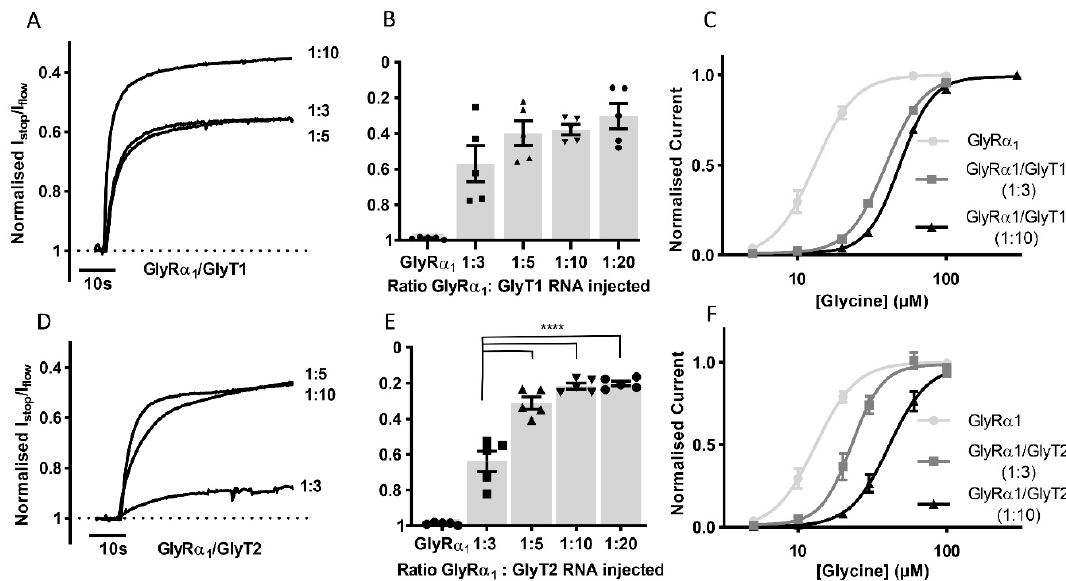
Figure 3. The impact of GlyT expression levels on GlyR α 1 currents. Example traces from co-expressed oocytes expressing different ( A ) GlyT1 and ( D ) GlyT2 densities showing normalised I stop /I flow reduction of GlyR α 1 currents ( B , E ) Histograms show increasing the ratio of GlyR α 1 : GlyT cRNA injected in oocytes increases the normalised I stop /I flow ratio when co-expressed with GlyT2 but not GlyT1. Significance was tested using a one-way ANOVA and Dunnett’s post-hoc test and **** indicates p < 0.0001. No significant difference was found between values for different GlyT1 ratios. ( C , F ) Glycine dose responses for GlyR α 1 and GlyR α 1 /GlyT1 or GlyR α 1 /GlyT2 at 1:3 and 1:10 injected cRNA ratios. Fast flow currents were normalised to I max and fit to the Hill equation. Symbols are mean ± SEM, n = 5. Since the functional properties of tagged proteins were very similar to untagged